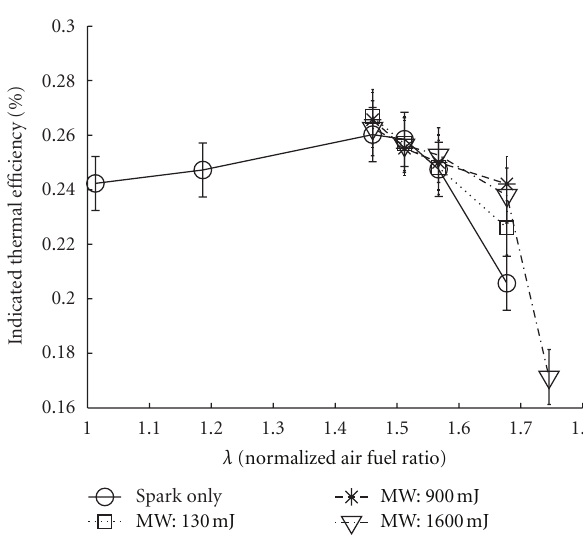
Figure 5: Addition of microwave energy increases thermal e ffi - ciency at λ = 1 . 68. Error bars are ± the uncertainty calculated using propagation of error (see Appendix A).